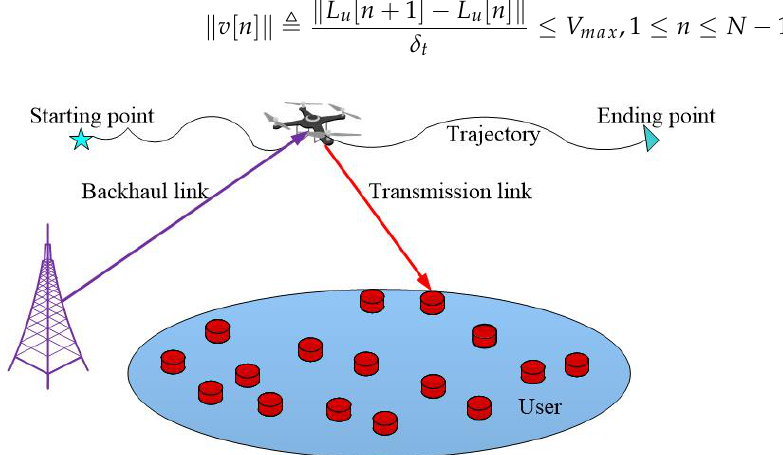
Figure 1. System